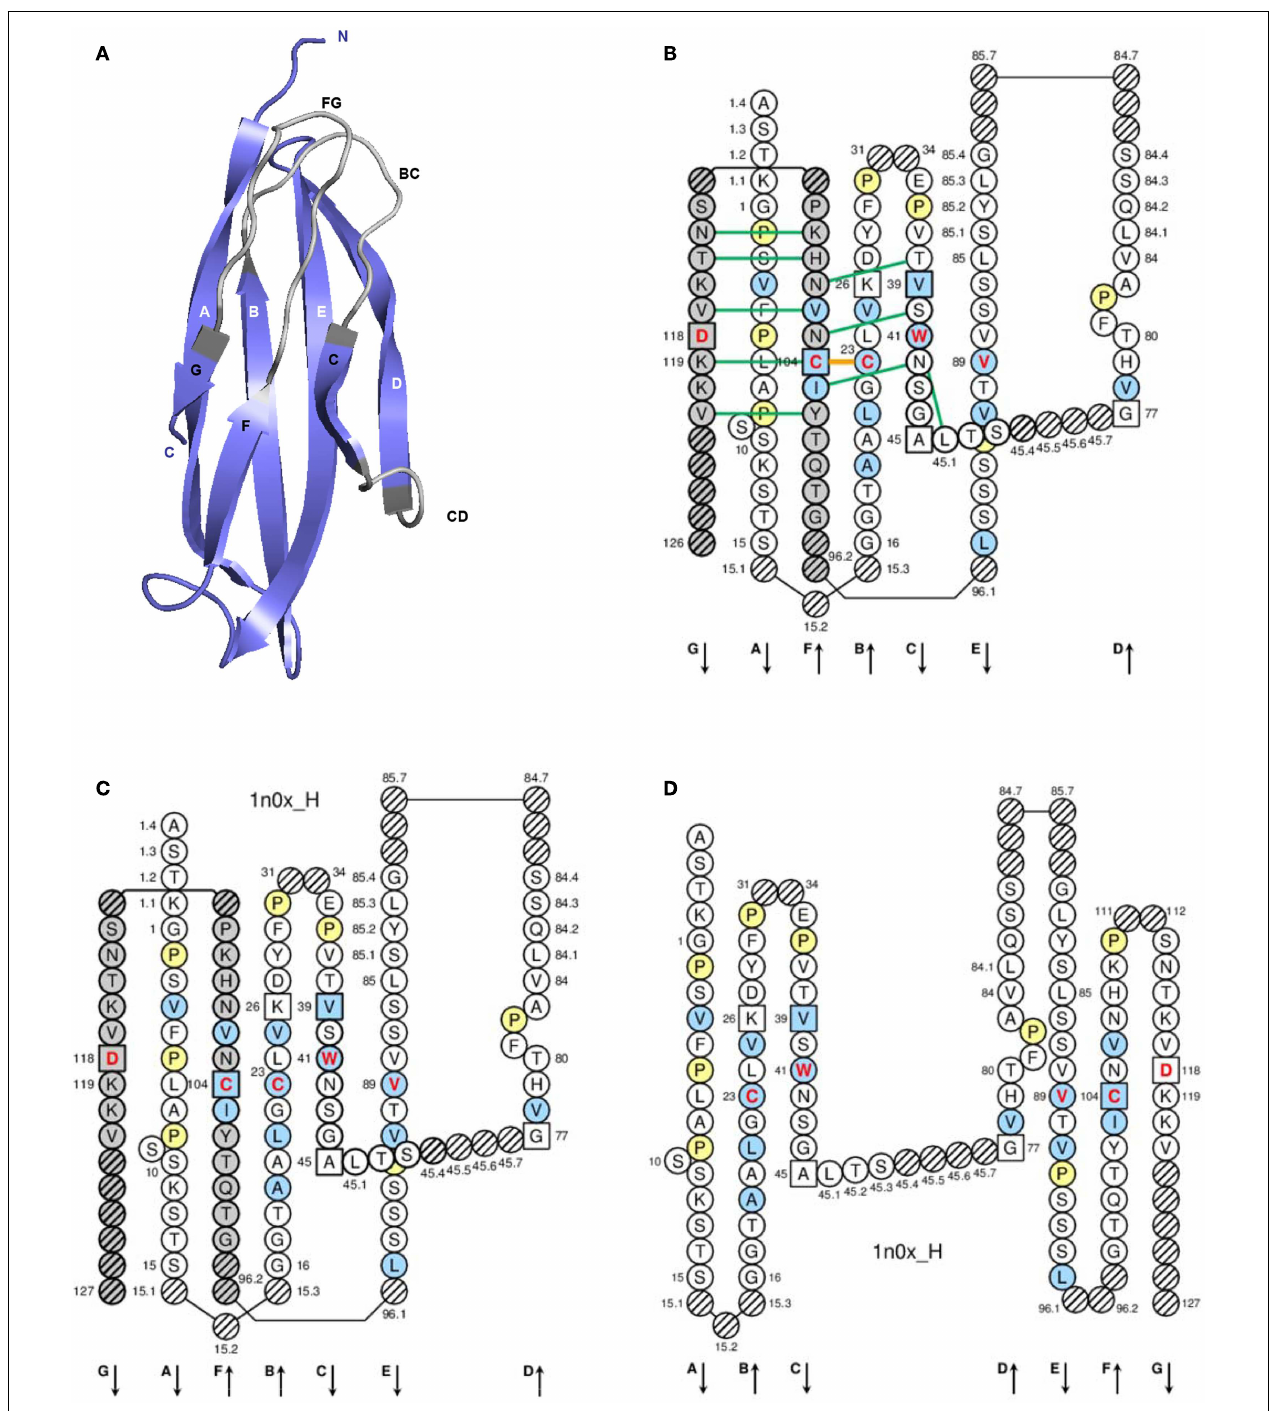
IMGT/3Dstructure-DB, from experimental 3D structure data (11–13). (C) IMGT Collier de Perles on two layers from IMGT/DomainGapAlign (12, 27, 28). (D) IMGT Colliers de Perles on one layer. Amino acids are shown in the one-letter abbreviation. All proline (P) are shown online in yellow. IMGT anchors are in square. Hatched circles are IMGT gaps according to the IMGT unique numbering for C-domain (65, 66). Positions with bold (online red) letters indicate the four conserved positions that are common to aV-domain